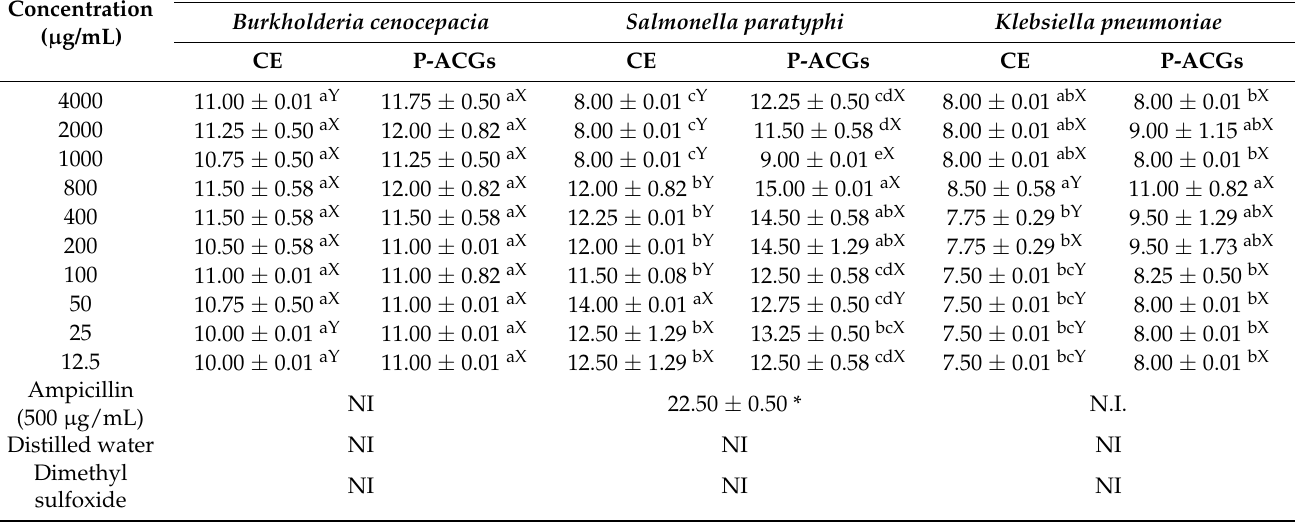
NI = no inhibition. Data are presented as averages ± the standard deviation. Significant statistical differences between concentrations are denoted by lowercase letters in the same column ( α = 0.05). Significant statistical differences between treatments are denoted by different capital letters ( α = 0.05). * = significant difference between the positive control and each treatment ( p <